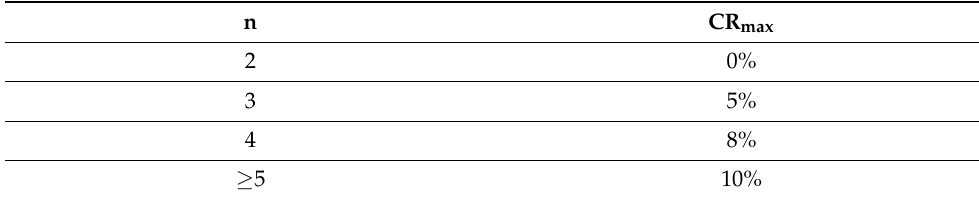
Table 5. Maximum percentages of the consistency ratio